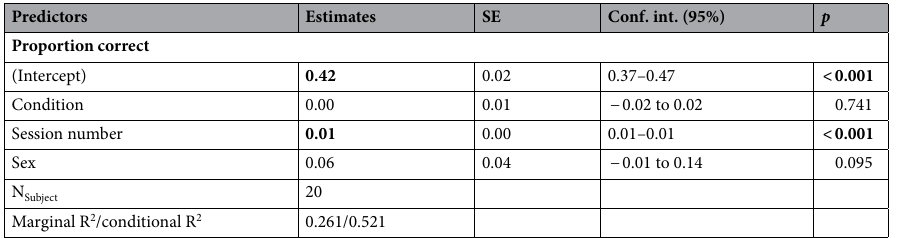
Table 1. Linear mixed-model of proportion correct predicted by pressure condition and session number, with subject included as a random effect. For the categorical predictor of pressure condition, the intercept is “high- pressure”; for categorical predictor of sex, the intercept is “female”. Significant estimates and their p values are